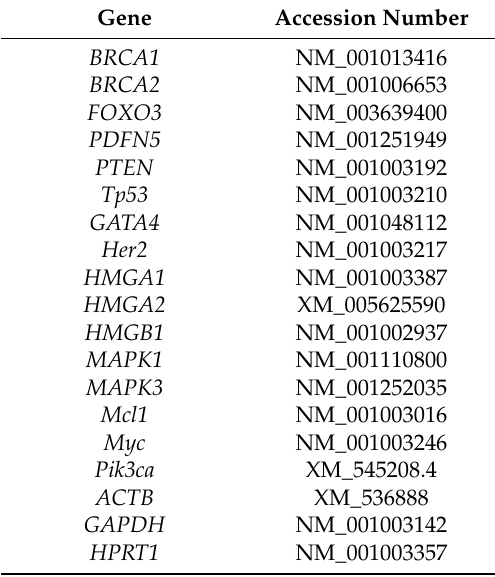
Table 3. Genes with their respective accession